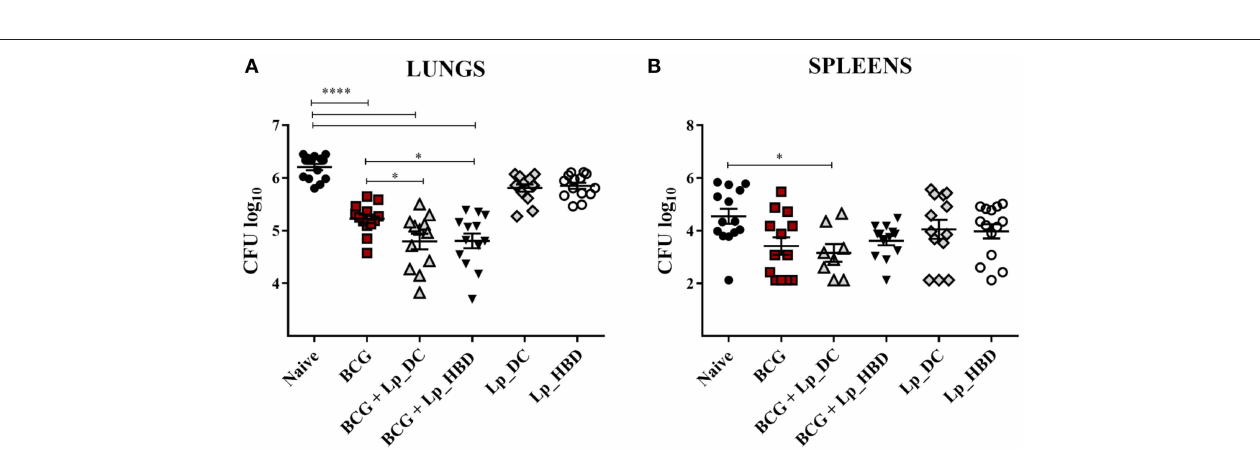
FIGURE 9 | Mycobacterial loads in lungs (A) and spleens (B) of mice immunized with Lp vaccines. Mice were administered with Lp _DC or Lp _HBD in a heterologous or a homologous immunization regimen, as shown in Figure 2 . Three weeks after the last vaccination, mice were infected with M. tuberculosis and 4 weeks later bacterial burdens were quantified in lungs and spleens. Results are presented as a cumulative data from two independent experiments and are shown as a mean ± SEM ( n = 12-14). Statistically significant differences were determined using one-way ANOVA with Tukey’s post-hoc test and are indicated as follows: * p < 0.05 and **** p <